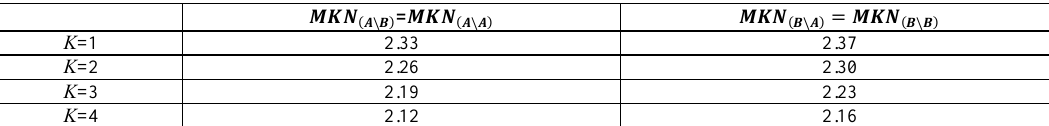
Table 2. MKN indices for time series A & B .